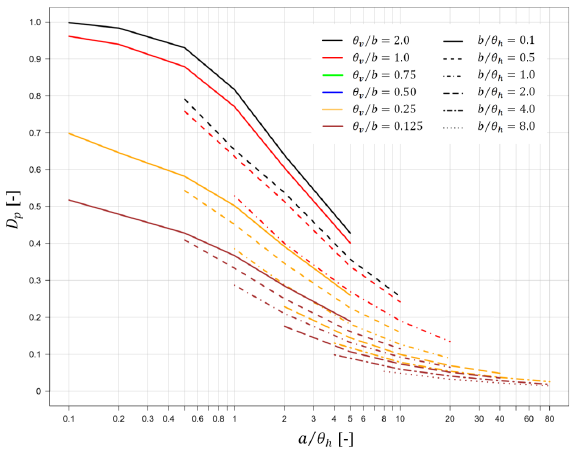
value for ratios θ p